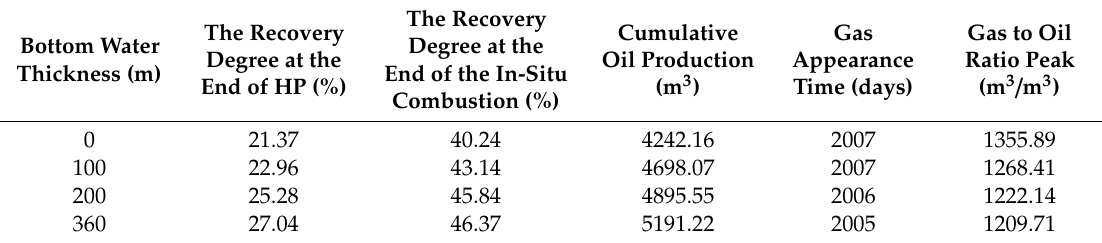
Table 11. Dynamic production indicators under di ff erent bottom water